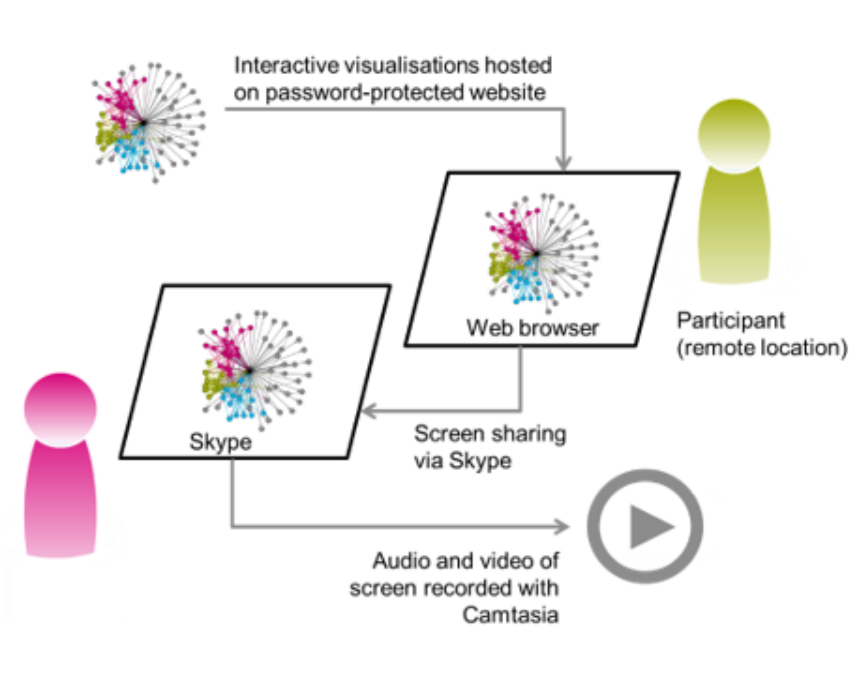
Figure 1. Technical setup for the online co-interpretive